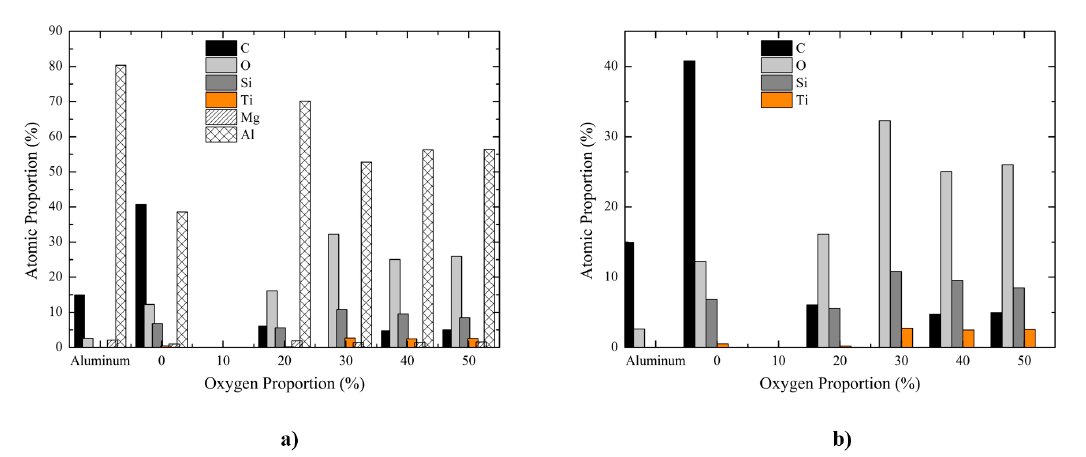
in the plasma. (b) Atomic 2 in the plasma, but without considering the elements 2